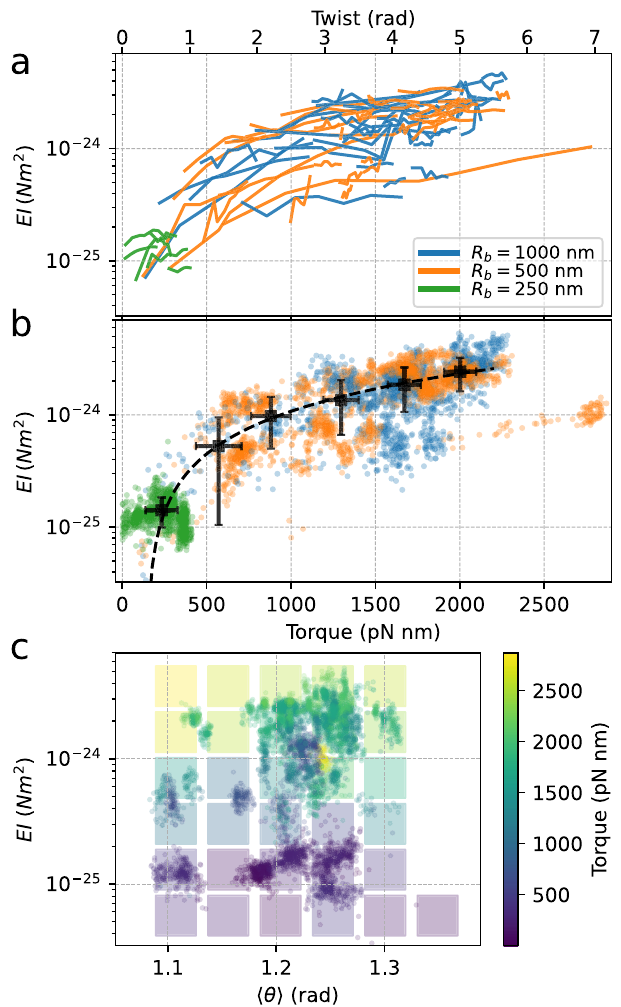
Fig. 5 Hook bending stiffness. a , b Bending stiffness as a function of motor torque τ (bottom axis) and twist angle (top axis, calculated from a constant value of the torsional stiffness), for the three loads considered. a the lines indicate the trajectories followed by individual motors during resurrection. b all the experimental points (one for each time-window) are shown, and are binned together in six points (black points represent the mean ± SD in each bin). The dashed line is a linear fi t to the black points. c The experimental points are shown in the space ( EI , 〈 θ 〉 , τ ), where 〈 θ 〉 is a proxy for the bending angle, and the torque τ for the twist angle. The background colors indicate the average torque value in the corresponding region of the plane ( EI , 〈 θ 〉 ). The measurements, each on a different cell, consist of 36, 35, and 7 traces for motors at steady state and 6, 13, and 6 resurrection traces for beads of radius R b = 1000, 500, 250 nm,